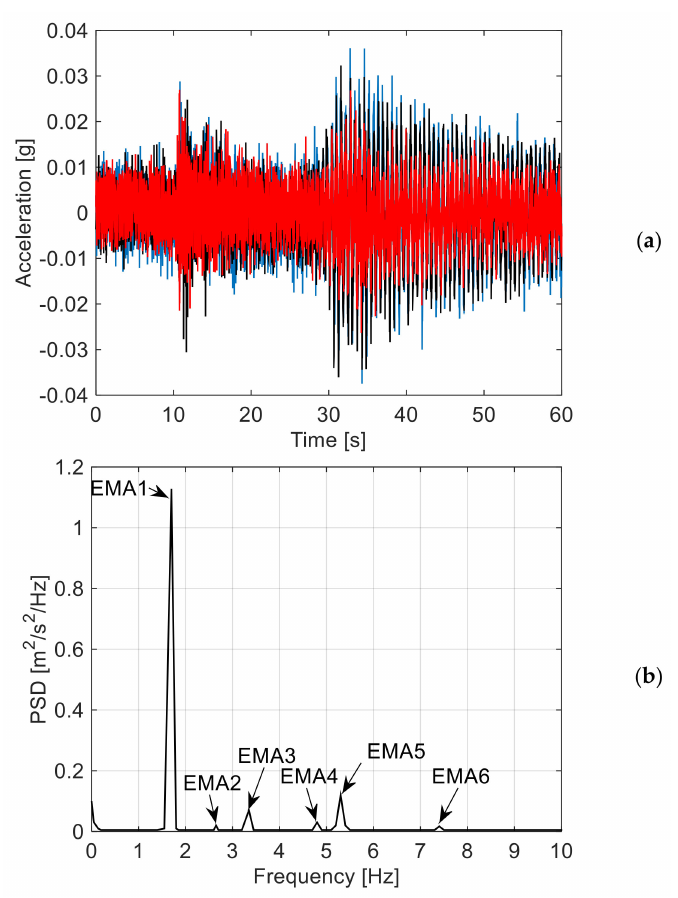
Figure 7. Dynamic identification of the Pietratagliata bridge via MEMS sensors: ( a ) example of test measurements (three sensors only are shown) and ( b ) pseudo spectral density with evidence of fundamental